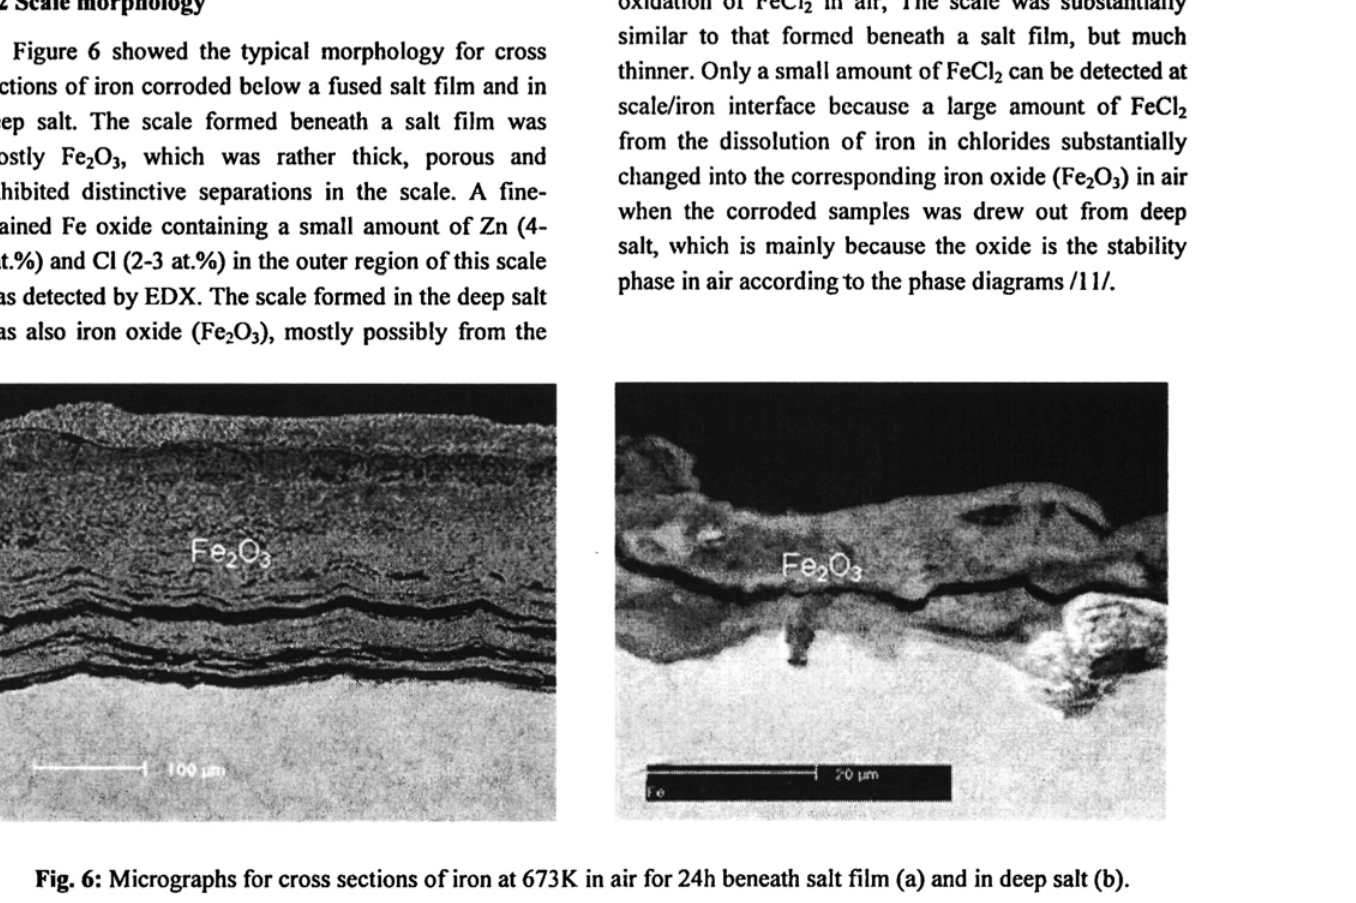
Fig. 6: Micrographs for cross sections of iron at 673K in air for 24h beneath salt film (a) and in deep salt (b). The corrosion of nickel beneath a salt film produced the porous NiO scale containing some K, Zn and Cl, as shown Figure 7. In addition, a small amount of chlorine (3-4 at.%) was detected at the scale/substrate interface.